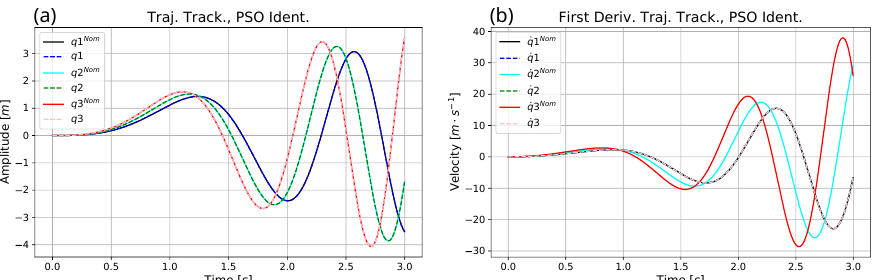
Figure 3. Trajectory tracking ( a ) and the first time derivatives ( b ) for the three robot links in the parameter identification process.